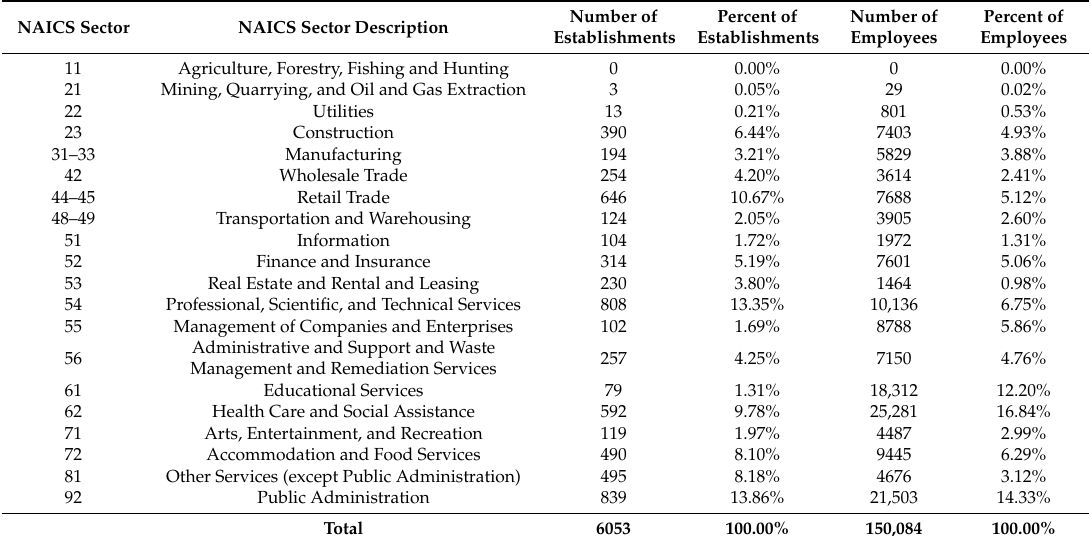
Table 2. Distribution of business establishments and employees in the sectors of the North American Industry Classification System (NAICS) in Richmond,